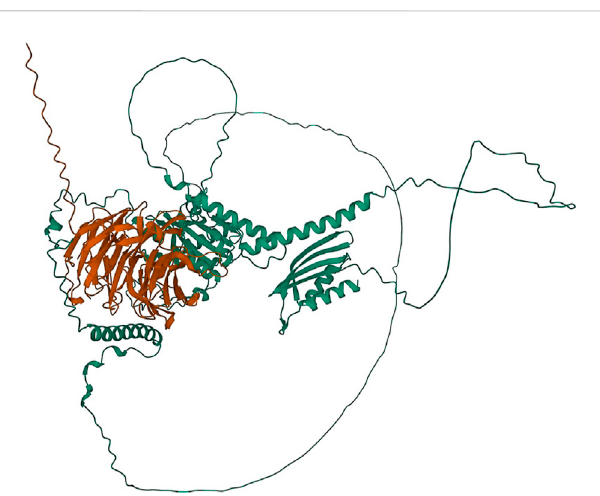
FIGURE 7 Protein structures predicted for the Tan1-Tan2 multimer using AlphaFold two for the translated tan1b allele and the Tan2 annotated protein. Protein coils represent α helices and arrows represent β - pleated